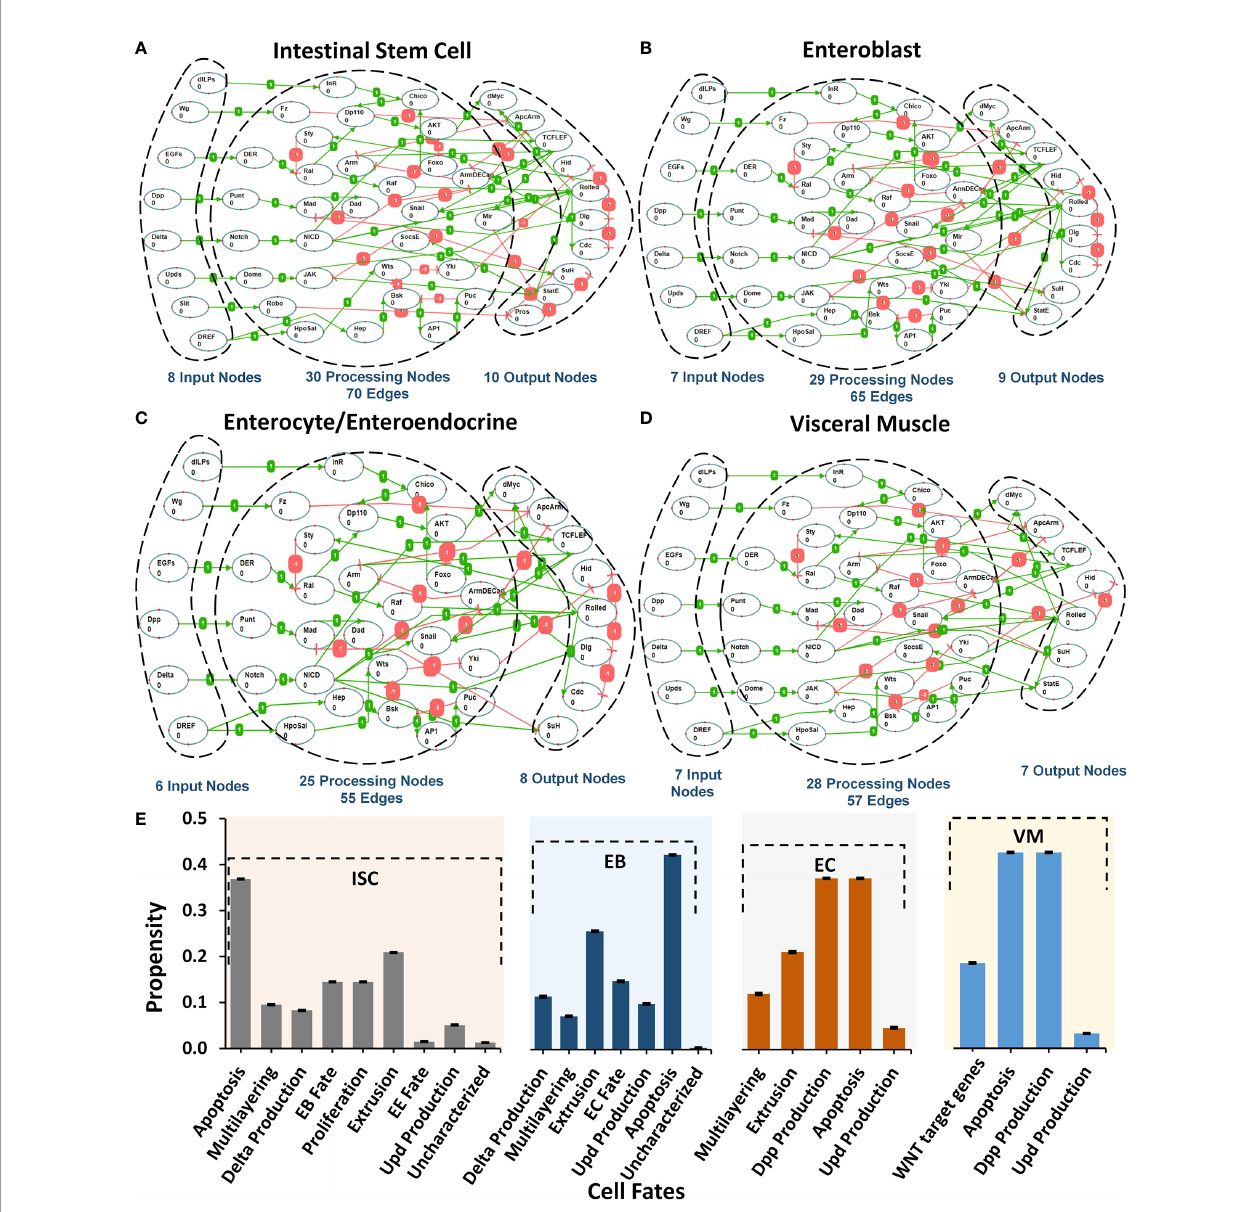
FIGURE 1 | Regulatory schema of networks for the fi ve cell types present in Drosophila melanogaster midgut. (A – D) The mapping between inputs, processing, and output nodes present in the biomolecular network models of fi ve cell types i.e. ISC, EB, EC/EE, and VM. (E) Cellular fate propensities for ISC, EBs, ECs, and VM, along with their respective